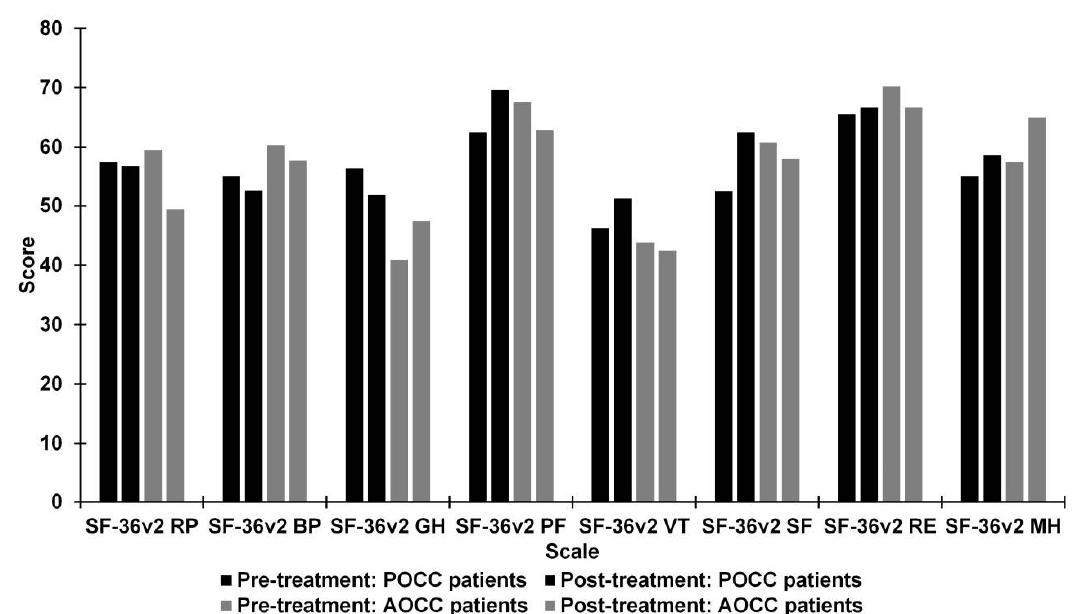
Figure 5. Differences between pre- and post-treatment in patients with presence optic chiasm compression (POCC) and patients with absence optic chiasm compression (AOCC) on Short-Form Health Survey version 2 (SF-36v2) scores. SF-36v2: BP = Bodily Pain; GH = General Health; MH = Mental Health; PF = Physical Functioning; RE = Role Emotional; RP = Role Physical; SF = Social Functioning; VT = Vitality.